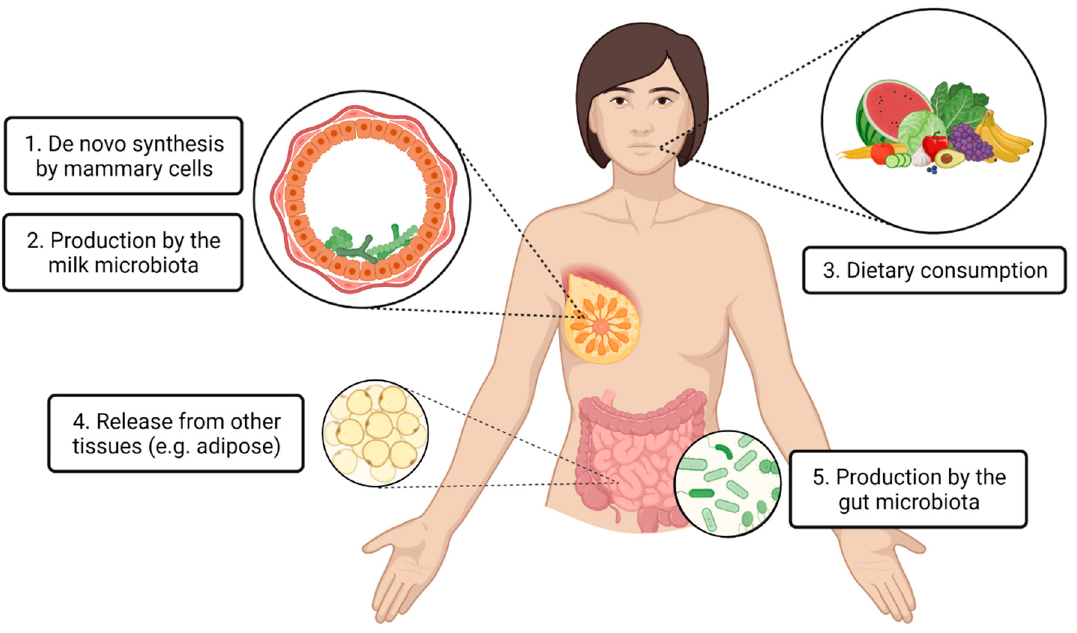
Figure 1. Proposed origins of lipids and small metabolites found in human milk. Local production within the mammary gland ( 1 , 2 ) and transport from distal body locations via the circulatory system ( 3 , 4 , 5 ) are hypothesized.